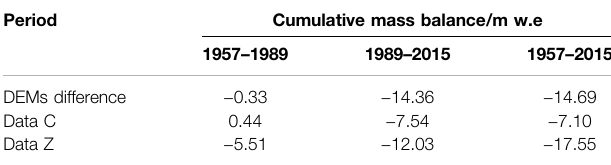
TABLE 3 | Comparison of Data C, Data Z, and DEMs difference result, 1957 – 2015.